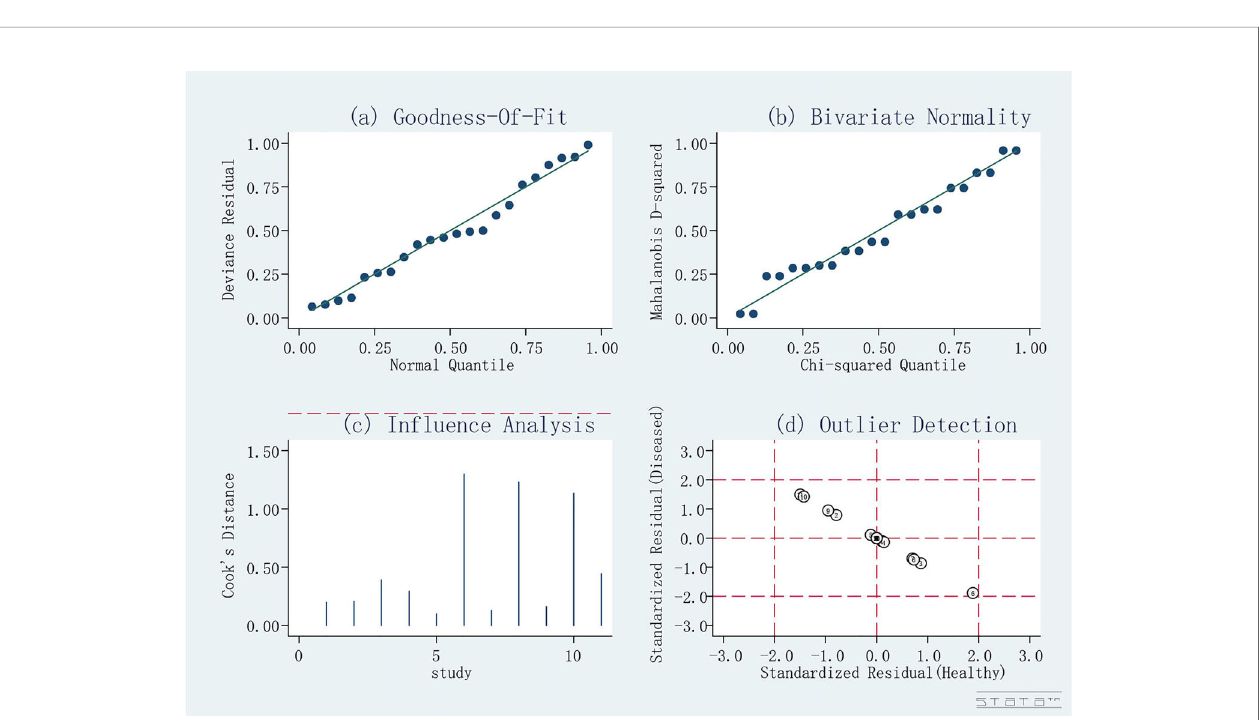
FIGURE 7 | Sensitivity